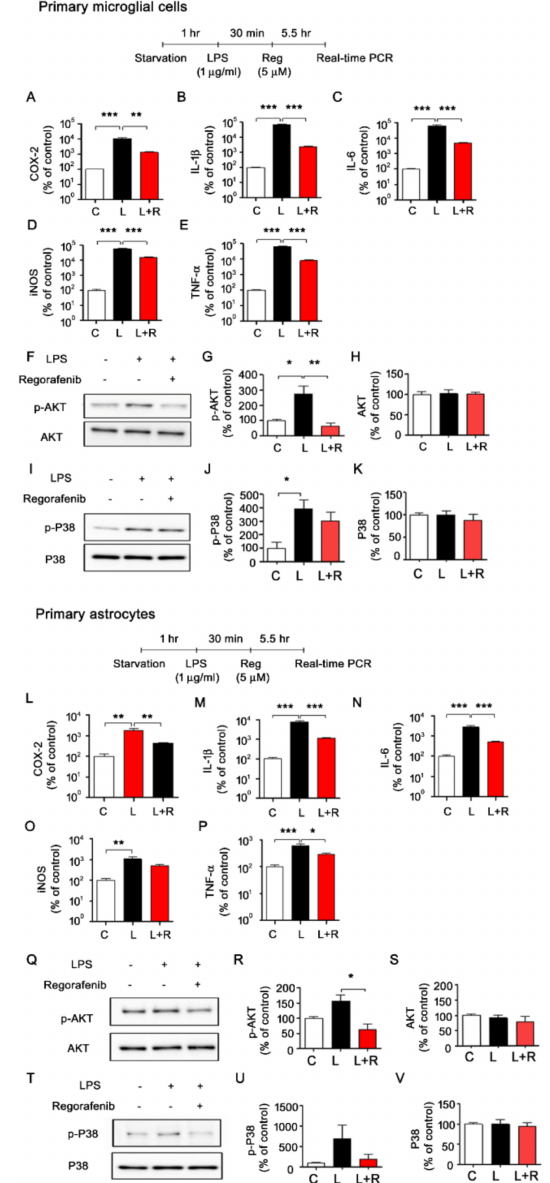
Figure 3. Regorafenib regulates LPS-induced proinflammatory cytokine levels in primary microglia and astrocytes. ( A – E ) Primary microglial cells were pretreated with LPS (1 µ g / mL) or PBS for 30 min, followed by treatment with regorafenib (5 µ M) or vehicle (1% DMSO) for 5.5 h and measurement of proinflammatory cytokine levels (n = 4 / group). ( F – K ) Primary microglial cells were pretreated with LPS (1 µ g / mL) or PBS for 45 min, followed by treatment with regorafenib (5 µ M) or vehicle (1% DMSO) for 45 min and western blotting with anti-p-AKT, anti-AKT, anti-p-P38, or anti-P38 antibodies (n = 3 / group). ( L – P ) Primary astrocytes were pretreated with LPS (1 µ g / mL) or PBS for 30 min, followed by treatment with regorafenib (5 µ M) or vehicle (1% DMSO) for 5.5 h and measurement of proinflammatory cytokine levels (n = 4 / group) ( Q – V ) Primary astrocytes were pretreated with LPS (1 µ g / mL) or PBS for 45 min, followed by treatment with regorafenib (5 µ M) or vehicle (1% DMSO) for 45 min and western blotting with anti-p-AKT, anti-AKT, anti-p-P38, or anti-P38 antibodies (n = 3 / group). * p < 0.05, ** p < 0.01, *** p <